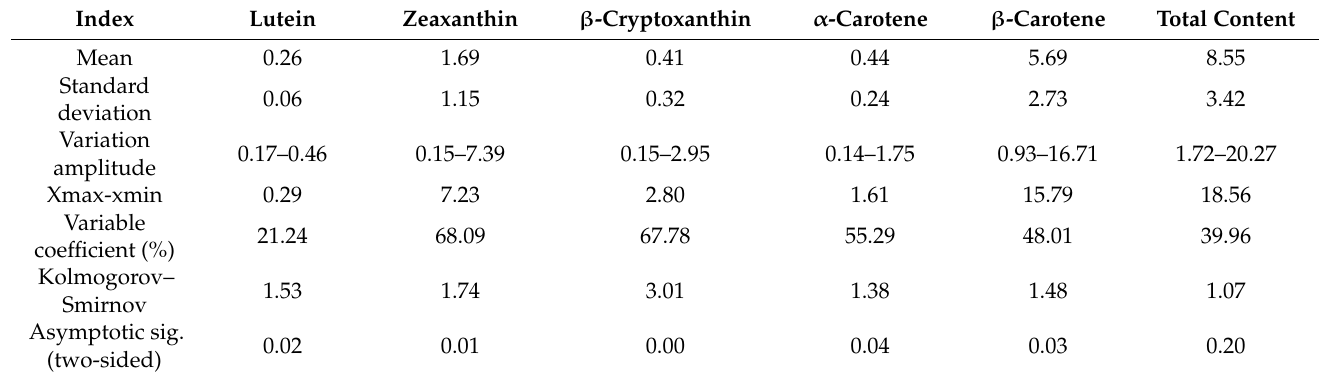
Table 1. Variations in the carotenoid content of yellow-flesh peach.